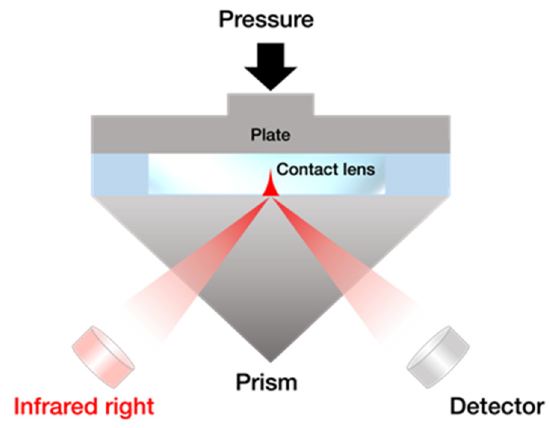
Molecules 2022 , 27 , x FOR PEER REVIEW Figure 1. Schematic illustration of the pressure-controlled ATR-IR method. Figure 1. Schematic illustration of the pressure-controlled ATR-IR method.